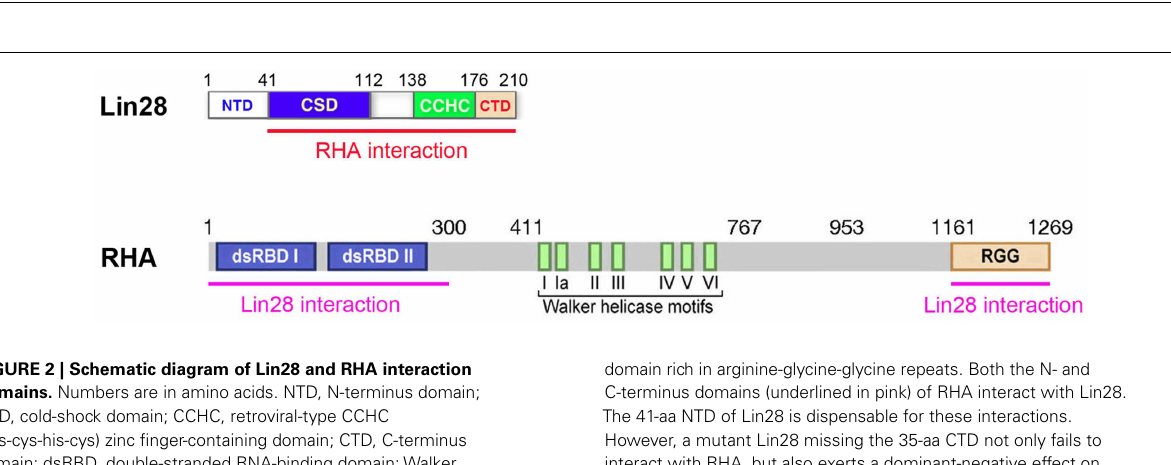
FIGURE 2 | Schematic diagram of Lin28 and RHA interaction domains. Numbers are in amino acids. NTD, N-terminus domain; CSD, cold-shock domain; CCHC, retroviral-type CCHC (cys-cys-his-cys) zinc finger-containing domain; CTD, C-terminus domain; dsRBD, double-stranded RNA-binding domain;Walker helicase motifs, motifs of conserved DEAD-box RNA helicases; RGG,